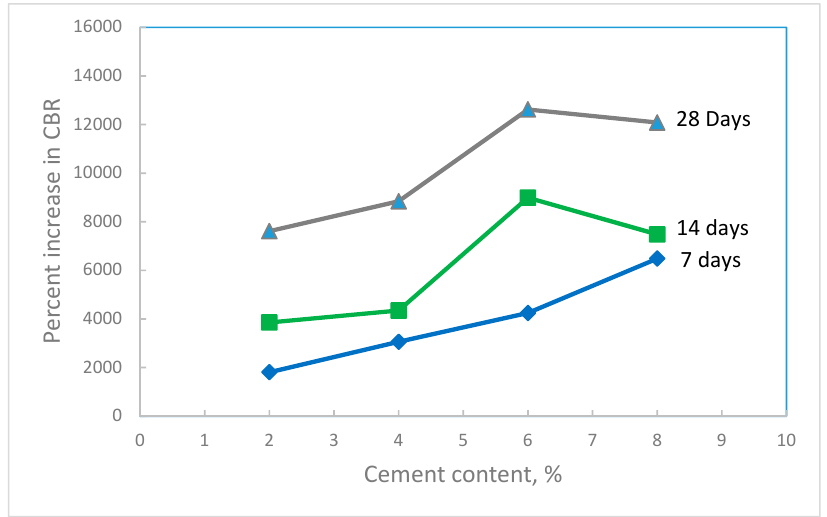
Figure 14. Percent increase in the CBR value of the treated waste sand with cement content for different curing times.